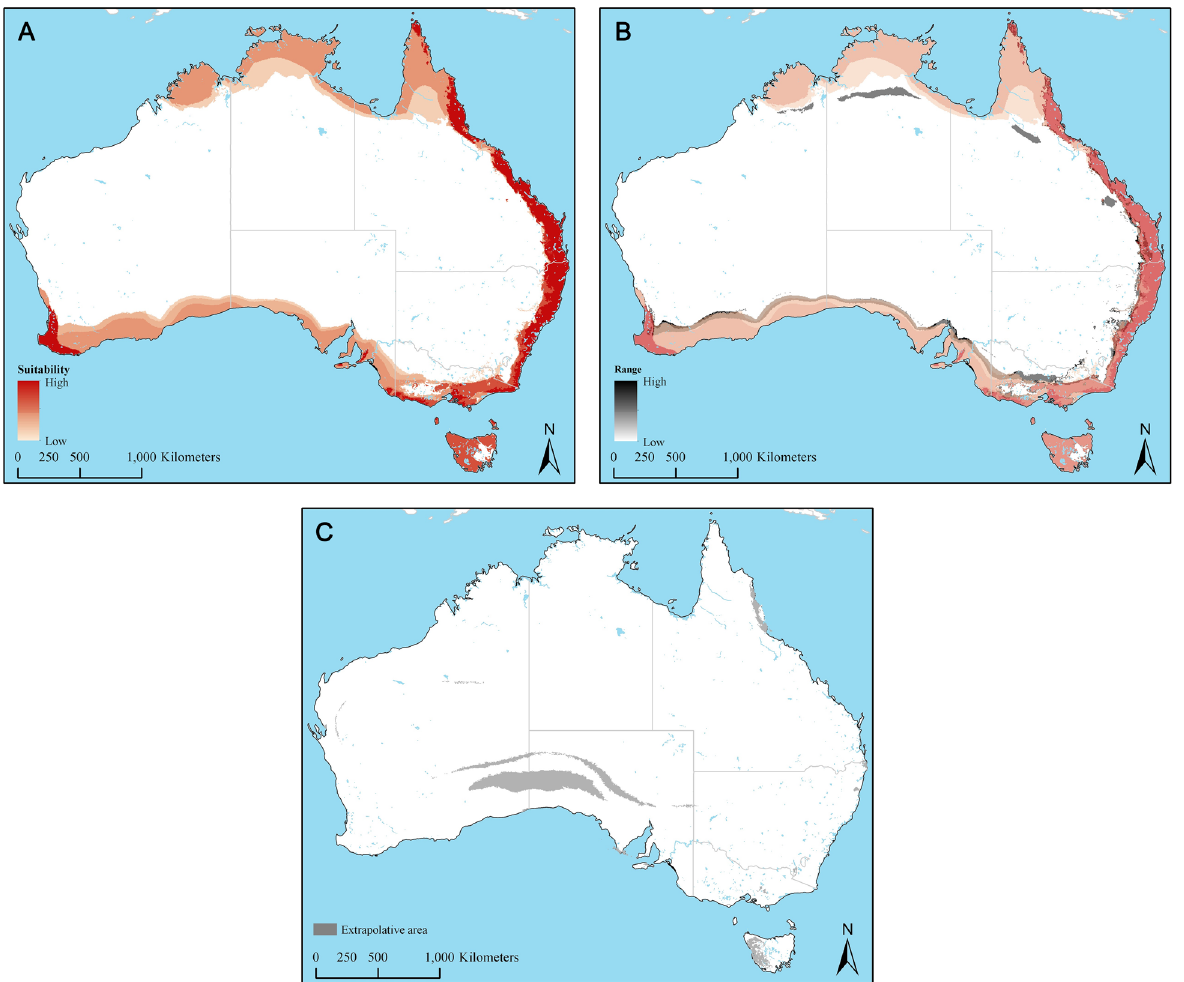
Figure 2. ( A ) Predicted median suitability for Ixodes holocyclus under present-day climate conditions. ( B ) Variability associated with predicted suitability under present day climate conditions represented by the range of predictions. Shades of red represent suitability; warmer colors indicate higher values of suitability. ( C ) Mobility- oriented parity (MOP) results under present day conditions, revealing strictly extrapolative